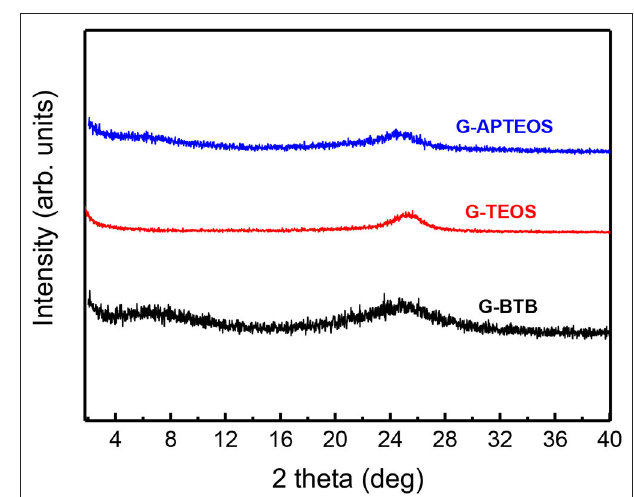
FIGURE 2 | XRD patterns of pristine graphite, graphene oxide, organo-modified GO (org-GO), and heterostructures prepared by silylation with the three different organosilane precursors: BTB, TEOS, and APTEOS (GO-BTB, GO-TEOS, GO-APTEOS).